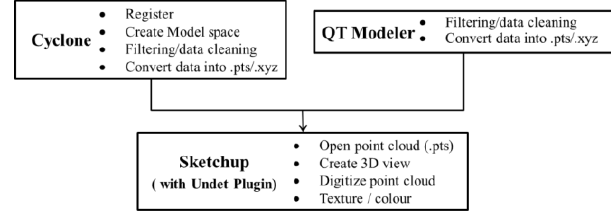
Figure 4. Simplified Method from point-clouds to 3D Modelling